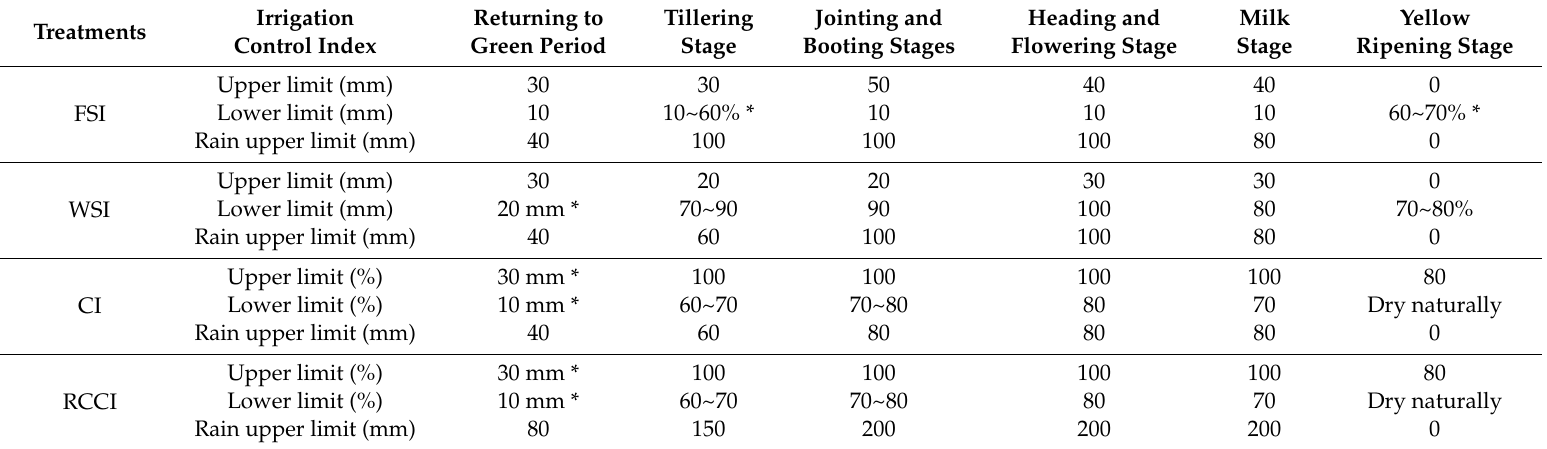
Table 1. Irrigation and drainage standards under di ff erent irrigation modes (Nanjing,